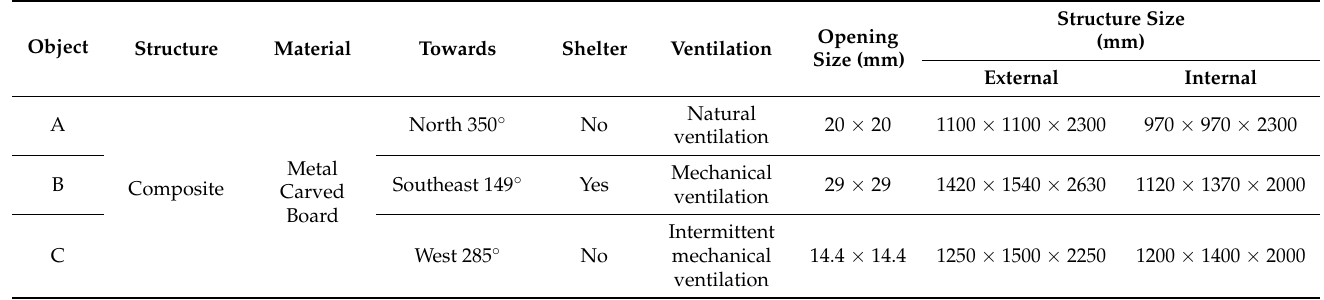
Table 1. Details for testing